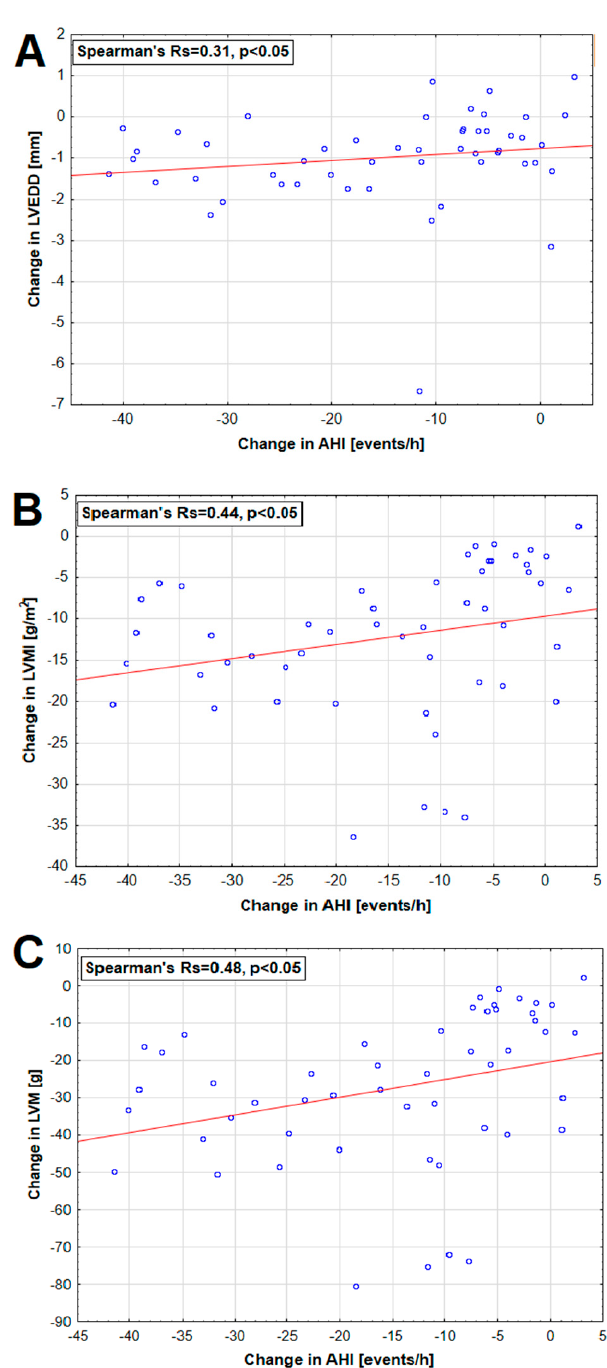
Figure 5. Relationship between change (Visit 1 and Visit 2) in AHI and change in ( A ) LVEDD, ( B ) LVMI, and ( C ) left ventricular mass (LVM) in patients receiving eplerenone.